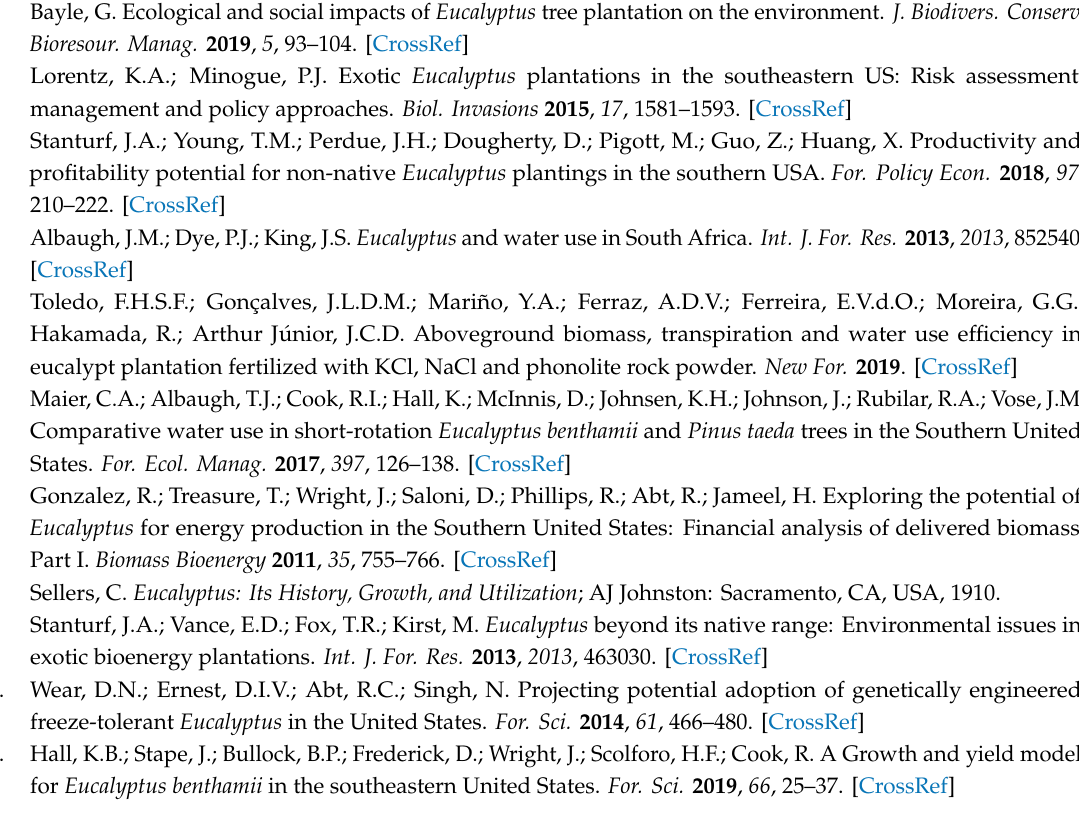
Figure S1: Precipitation and soil moisture during the field